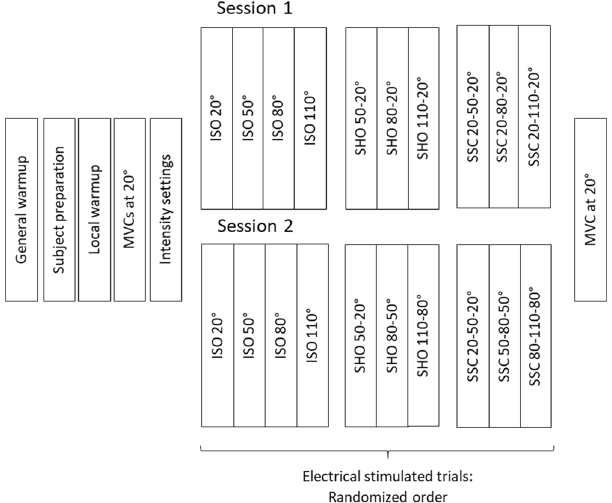
Figure 1. Experimental protocol. Each subject participated in two test sessions. Both test sessions comprised isometric fixed-end reference contractions (ISO), shortening-hold contractions (SHO) and stretch–shortening contractions (SSC). In session 1 the SHO- and SSC-magnitude and in session 2 the muscle–tendon unit length was